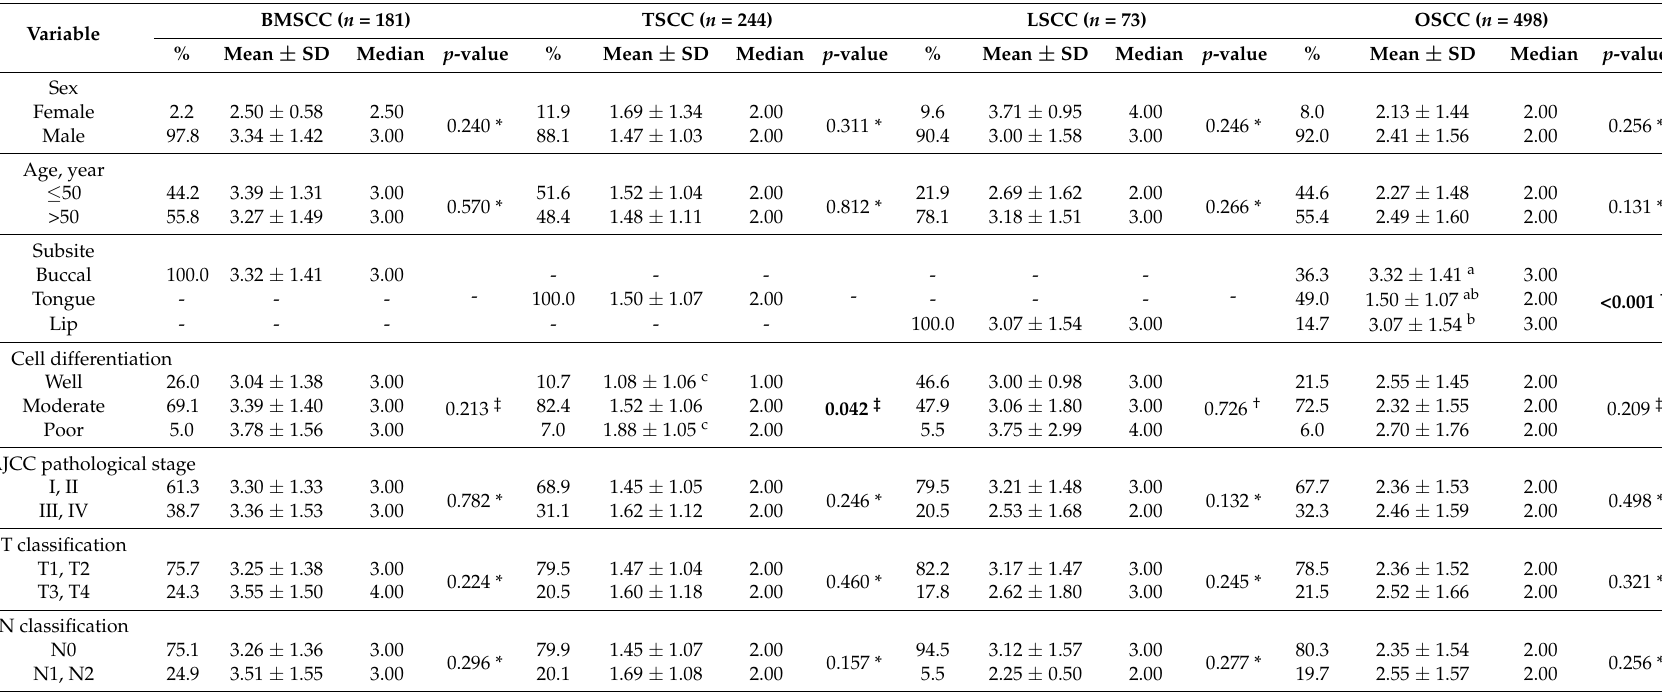
Table 2. Expression of MAP1LC3B and clinicopathologic outcomes in patients with OSCC and three primary